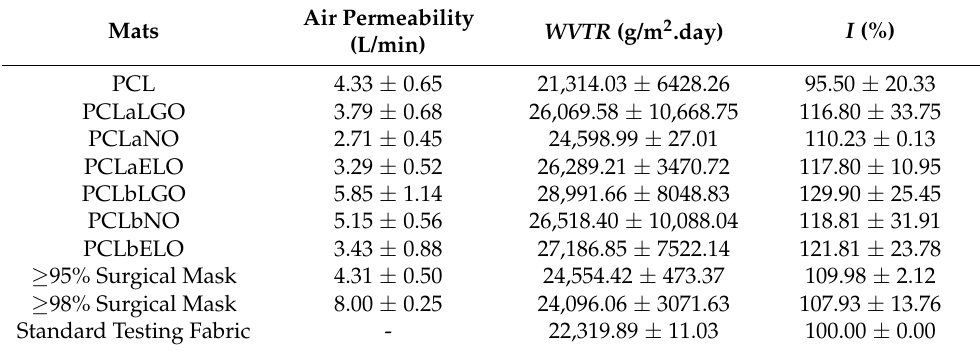
Table 7. Air and water vapor permeabilities, with determination of WVTR (g/m 2 .day) and I (%) for the